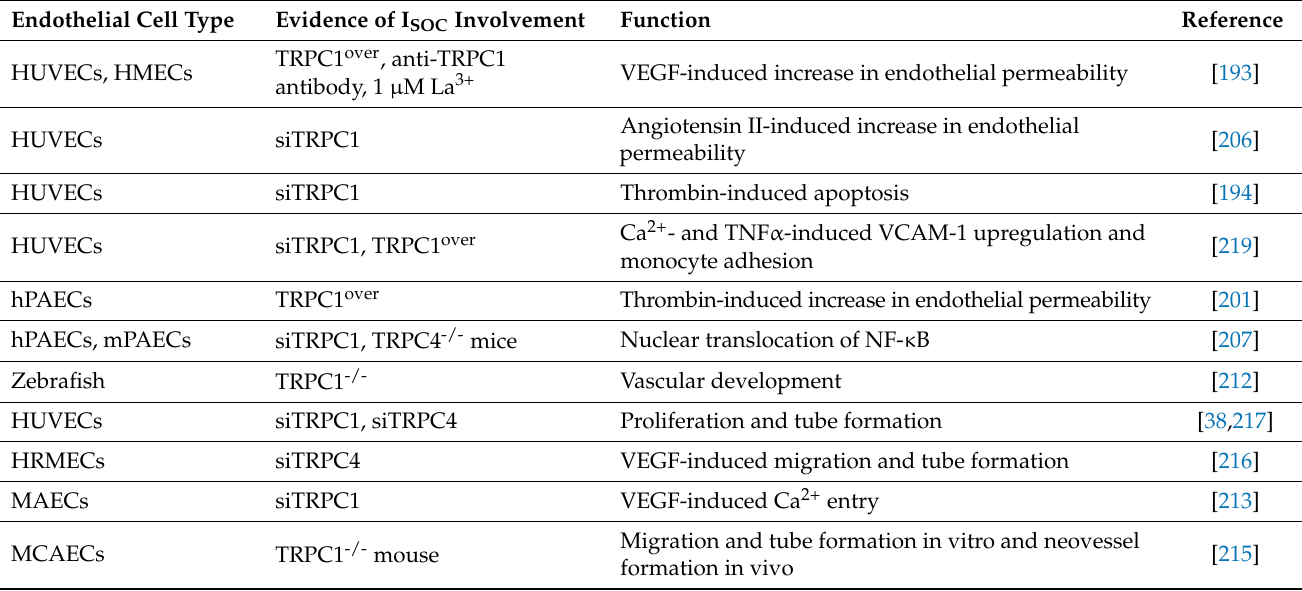
Table 6. Endothelial functions modulated by the I SOC